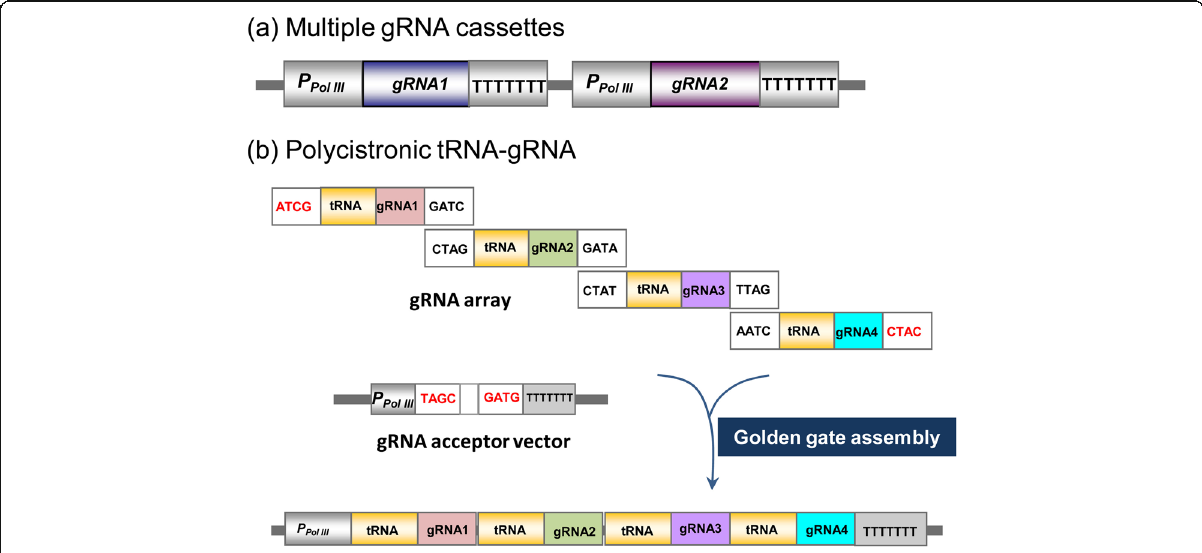
Fig. 2 Diagram of a plasmid construct used for multiplex genome editing. a Stacking of multiple sgRNA expression cassettes in one T-DNA. P Pol III : Polymerase III promoter. b Cloning of four tRNA-gRNAs into the CRISPR/Cas9 binary vector using a single Golden Gate ligation. (Modified from Kurata et al.